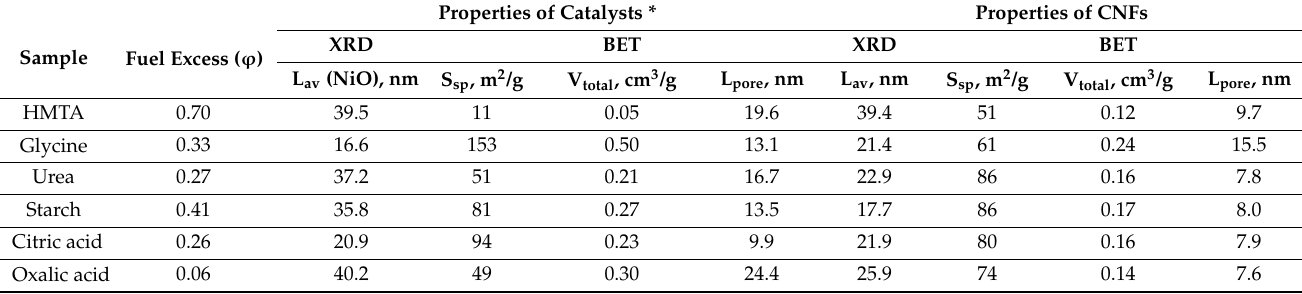
Figure 5. XRD patterns of carbon nanomaterials formed over solution combustion synthesized catalysts (450 ◦ C, 1 atm) ((002) reflection of carbon phase is shown in the figure). Table 2 shows summary of low temperature nitrogen adsorption data and XRD data. Table 2. Summary data on the properties of catalysts and CNFs.